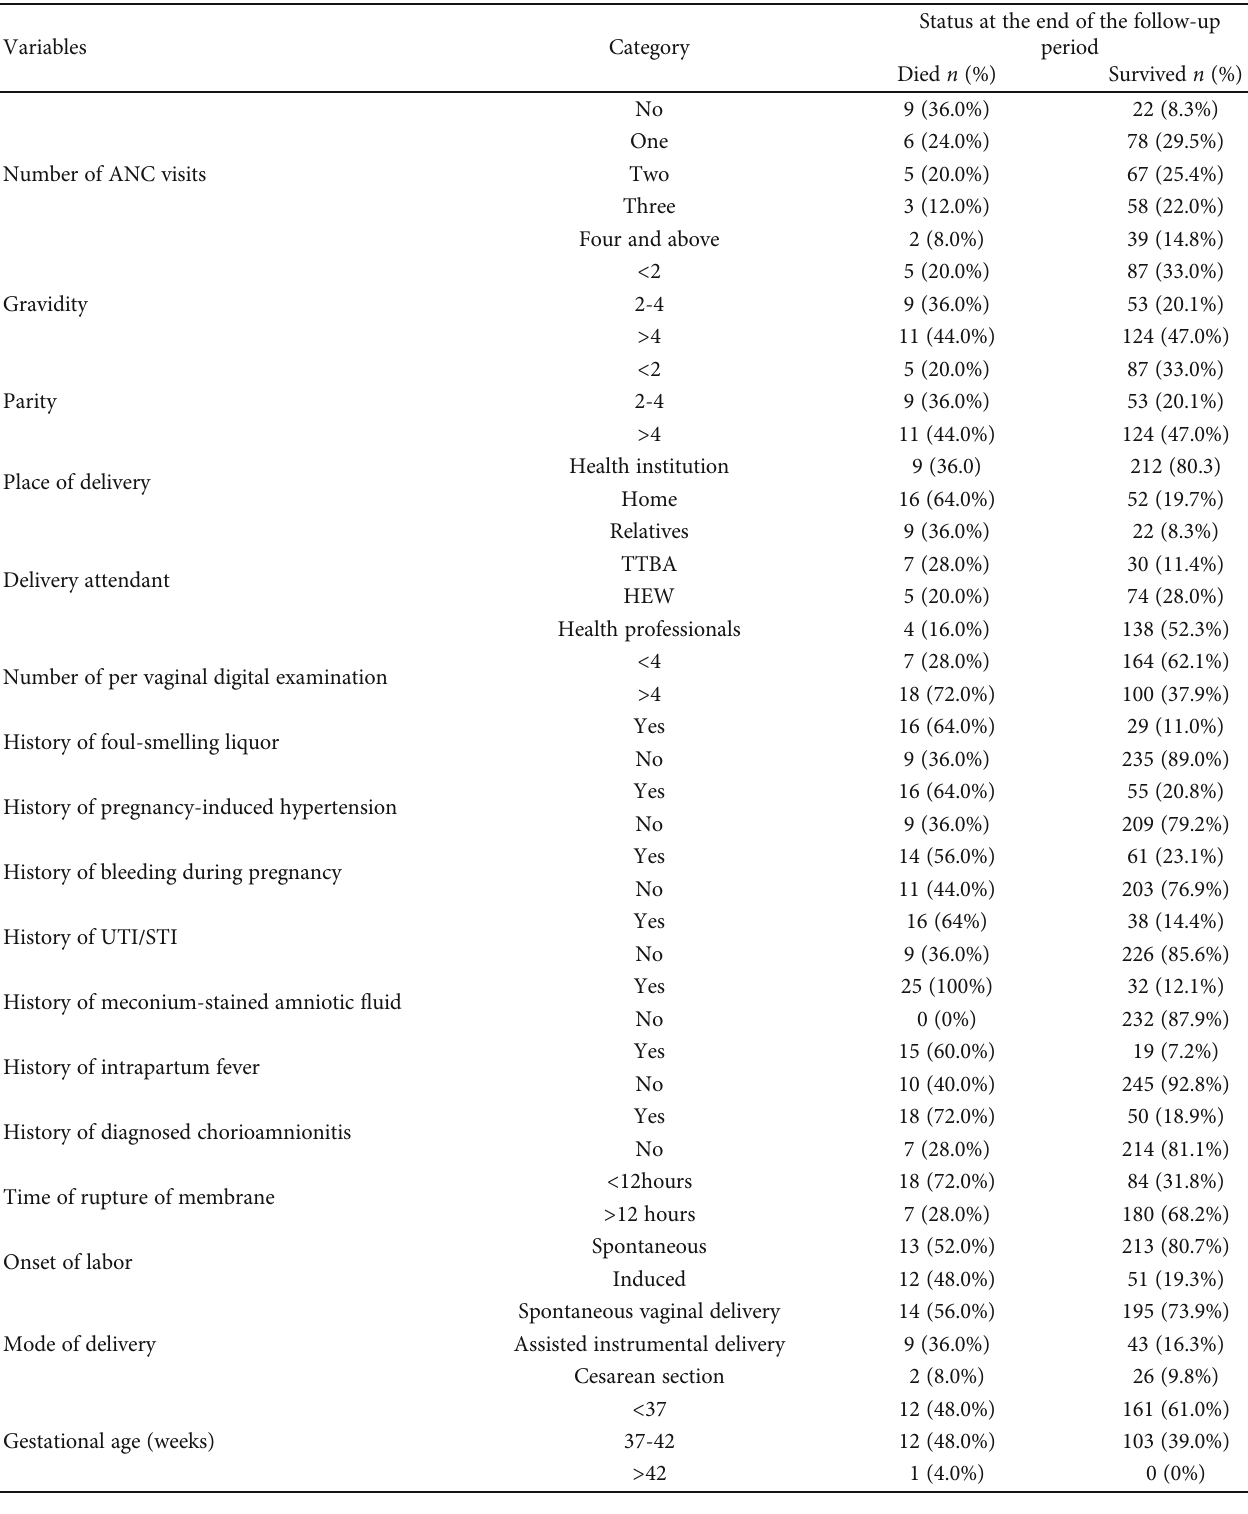
Table 2: Obstetrics-related characteristics of mothers having neonates with neonatal sepsis at public hospitals in Ethiopia.